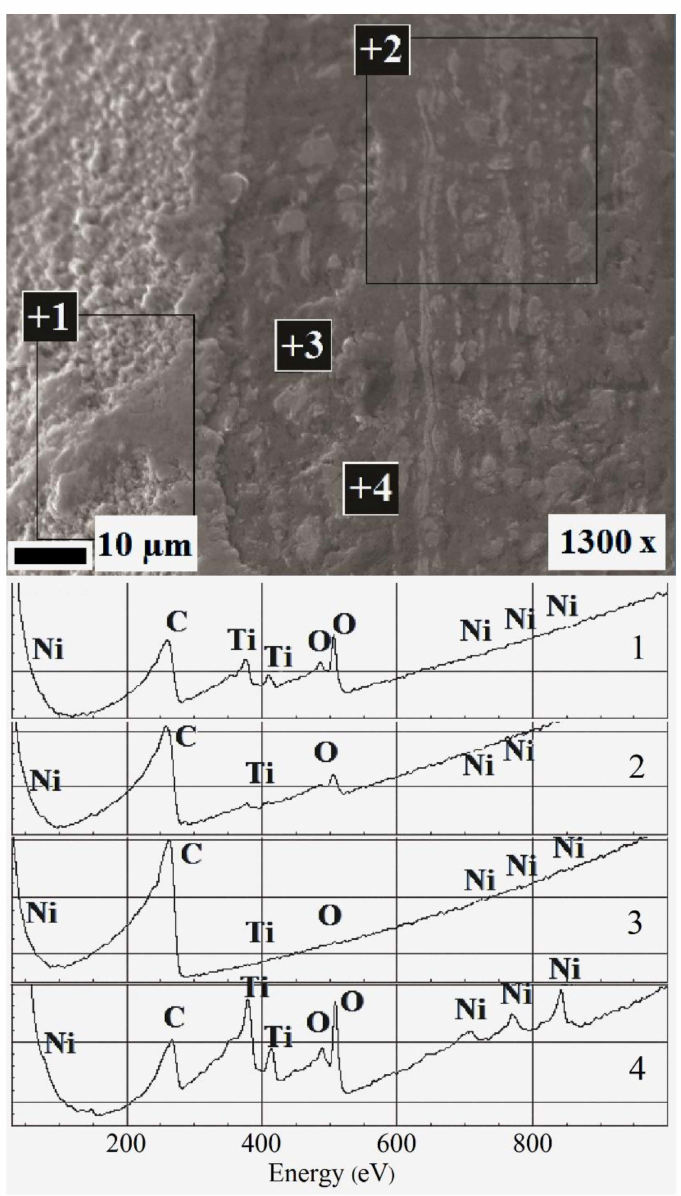
Figure 6. Surface structure of as-received nitinol after immersion in 0.9 wt % NaCl solution (Solution 4, Table 1) for two years. The Auger electron spectra (lower) were collected for the corresponding surface analysis areas